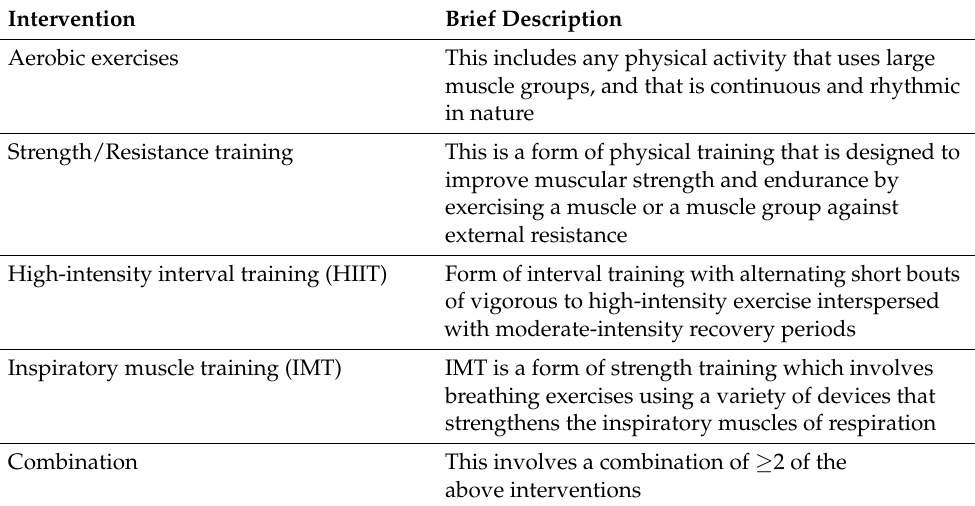
Table 3. Description of the exercise training